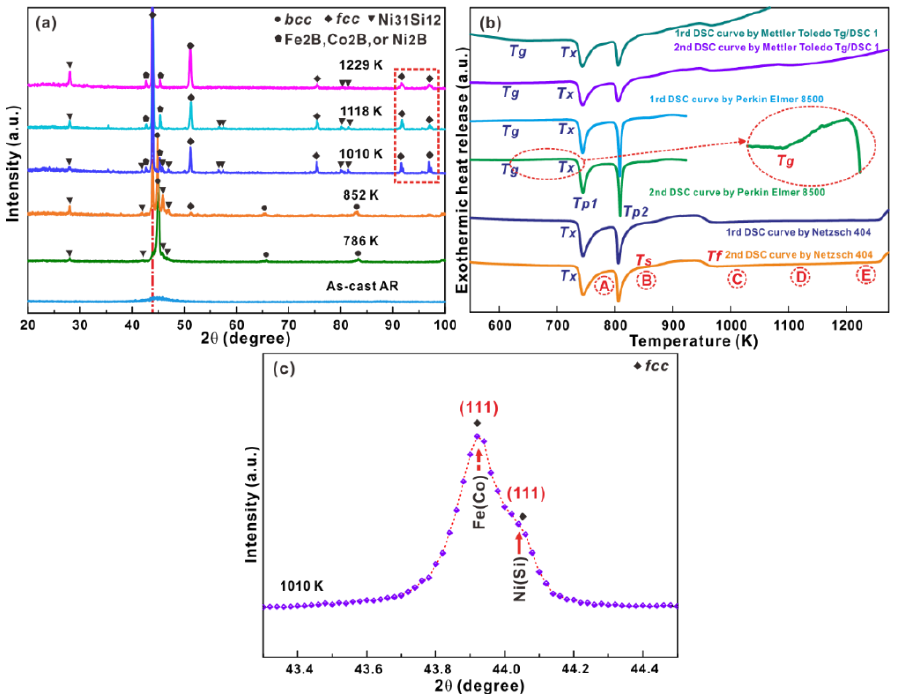
Figure 1. ( a ) X-ray diffraction patterns of the melt-spun AR ribbons and samples heated to different temperatures, ( b ) the DSC curve of the melt-spun AR ribbons measured by different DSC devices (inset: the glass transition zone), ( c ) the diffraction peaks of two type of FCC phases along the zone axis (111) for the AR sample heated to 1010 K, which were taken from Figure 1a.